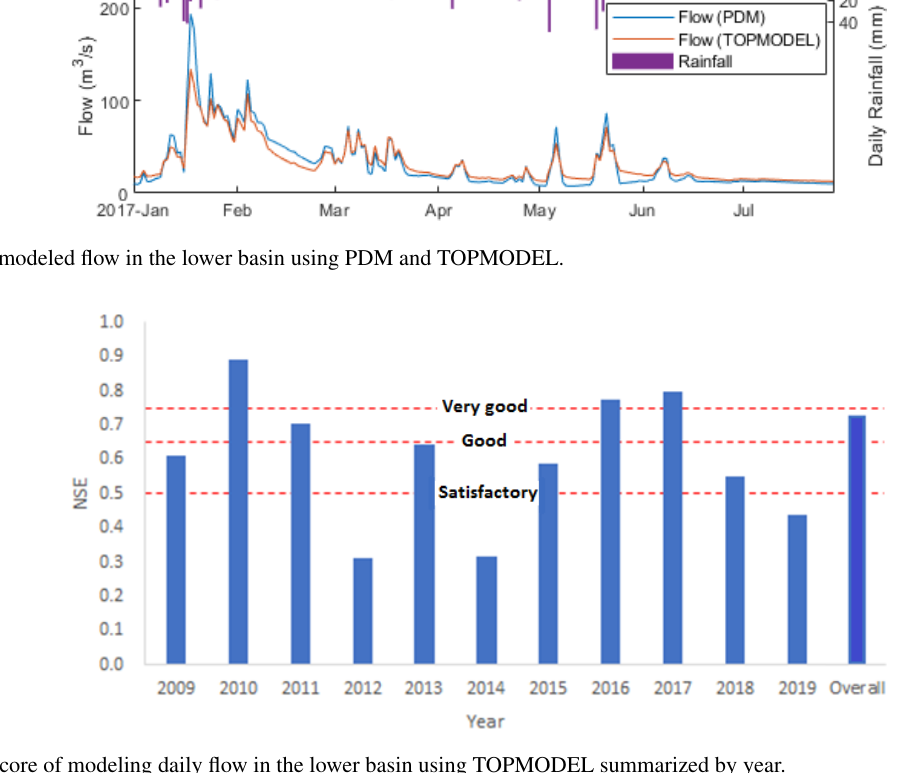
Figure 5. NSE score of modeling daily flow in the lower basin using TOPMODEL summarized by year.